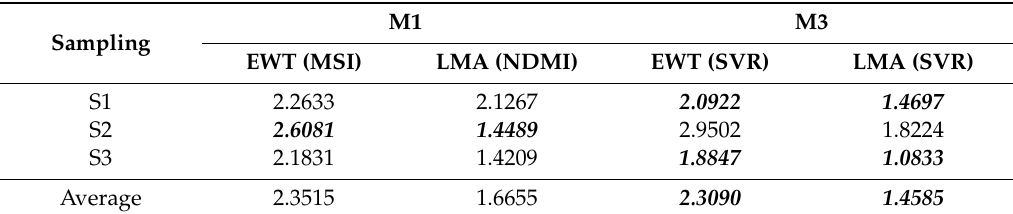
Table 8. RMSE of M1 and M3 for the estimation of leaf EWT and LMA. For M1, RMSEs were calculated using MSI and NDMI-based models, whereas RMSEs were calculated using SVR-VI-based models. The italic bold numbers represent better prediction